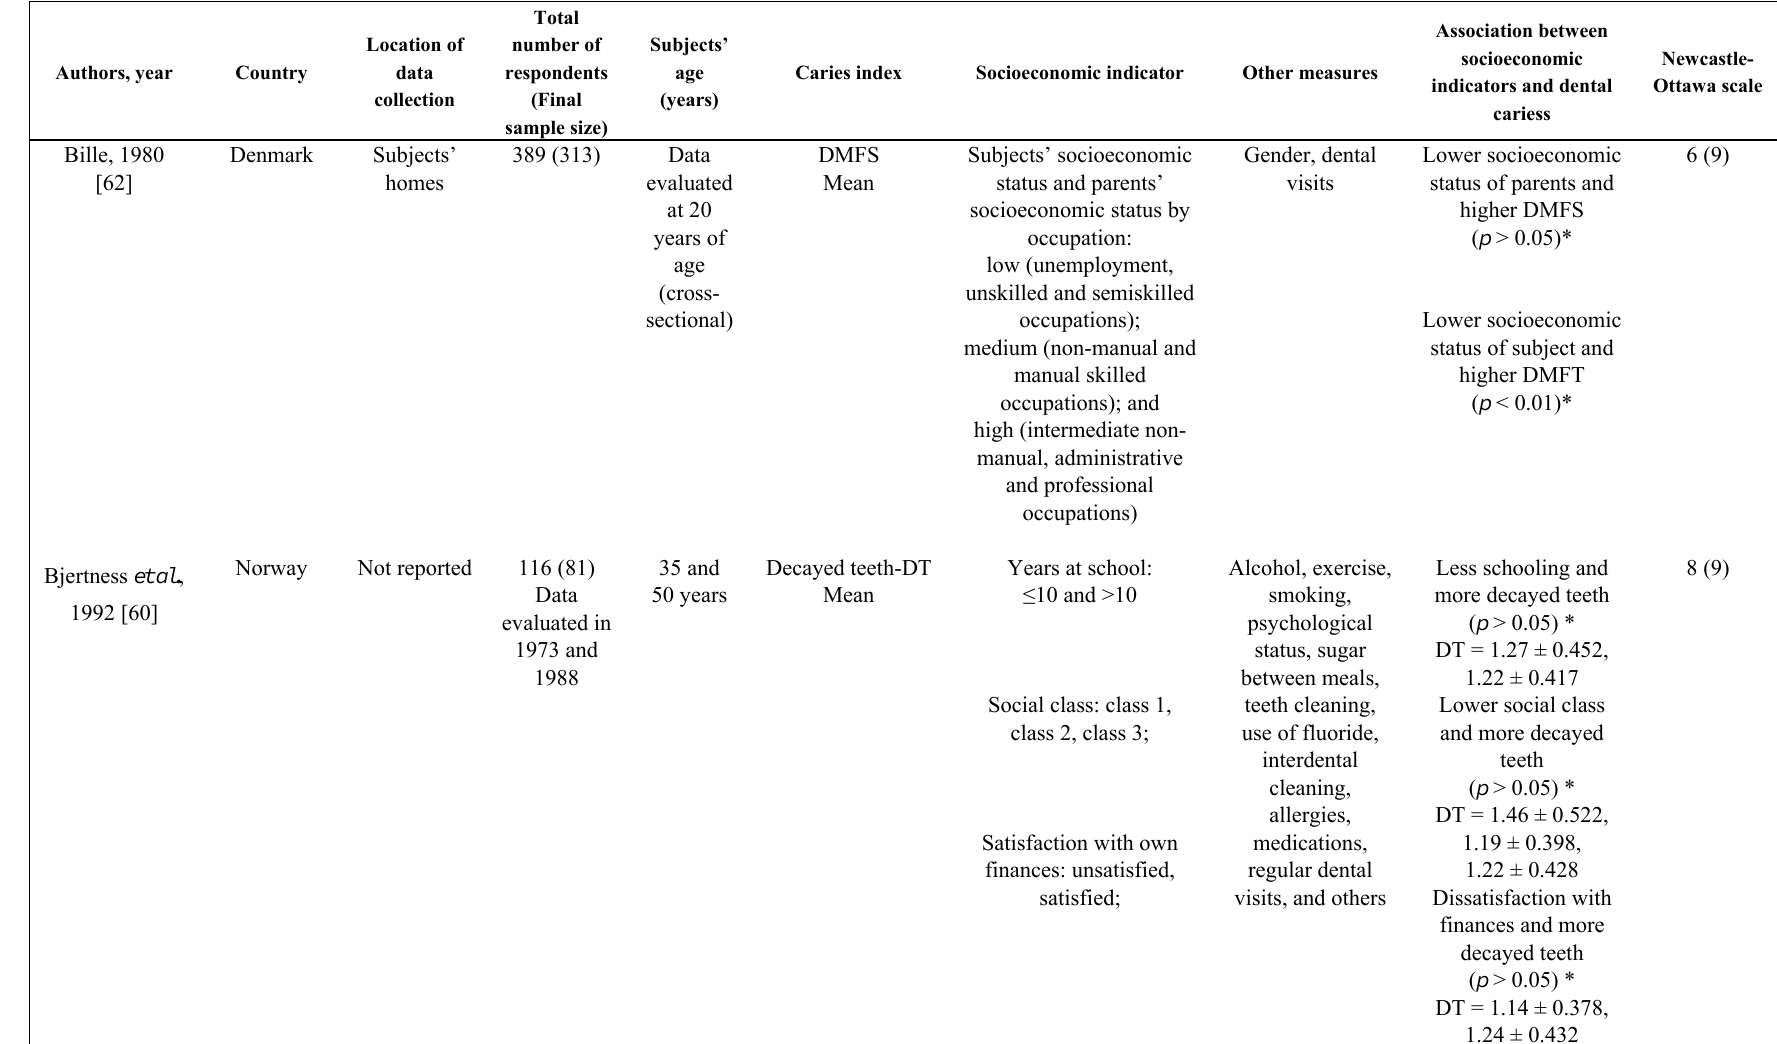
Table 2. Study characteristics and results from seven prospective cohort